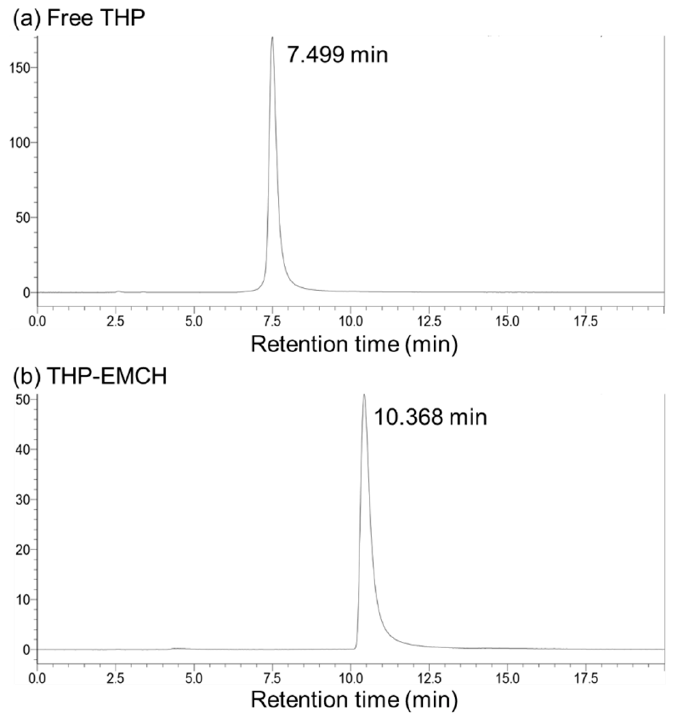
Figure 2. HPLC analyses of ( a ) free THP and ( b ) THP-EMCH. HPLC was performed on a Shimadzu HPLC system equipped with an RF-10AXL fluorescence detector (excitation at 488 nm, emission at 590 nm). See text for detail.